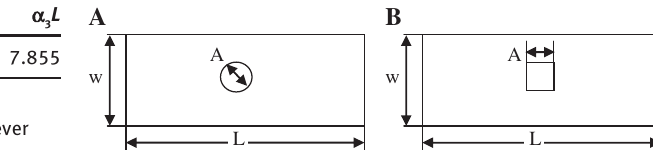
Figure 3 Laminated composite plate with cutout. (A) Circular cutout, (B) rectangular cutout.